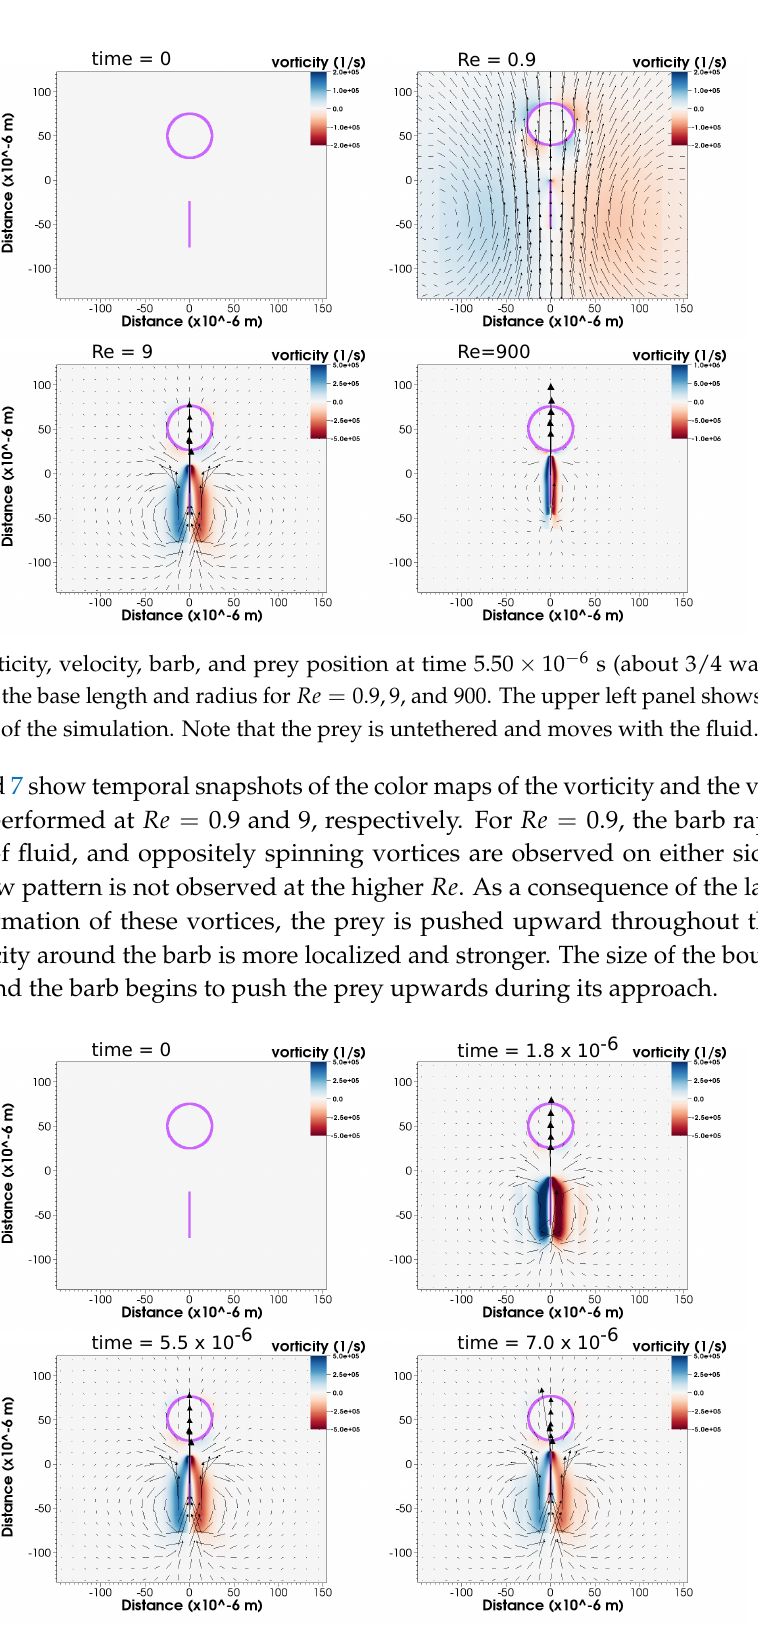
Figure 6. Temporal snapshots showing the vorticity and velocity vector field for Re = 9 at the base length and radius. The position of the barb and prey are denoted by magenta, the color map represents the vorticity, and the arrows indicate the fluid velocity. Note that the prey is untethered and moves with the